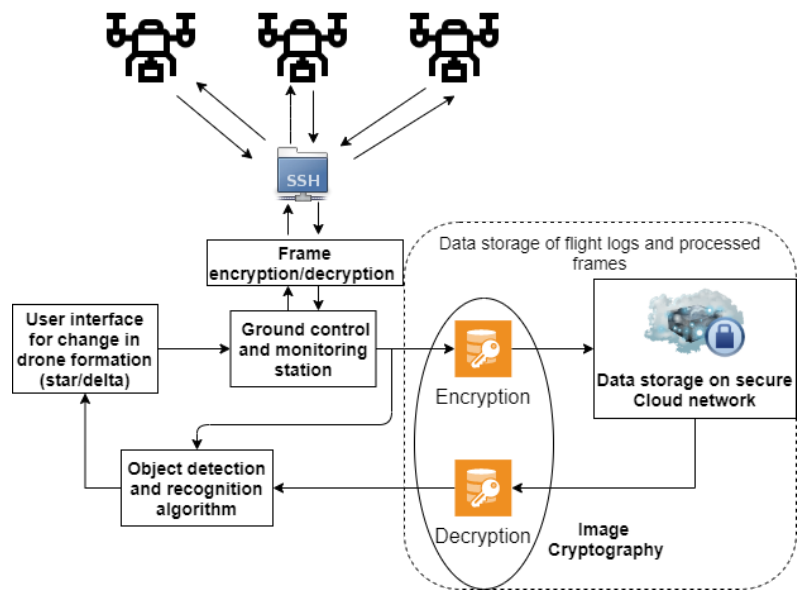
Figure 1. End-to-end communication between individual drone and ground